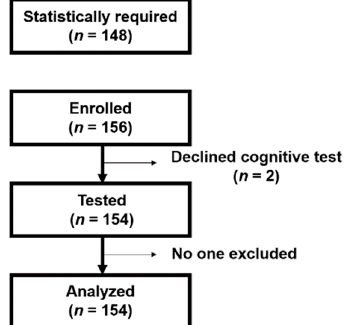
Figure 1. The flow chart of participants’ recruitment .